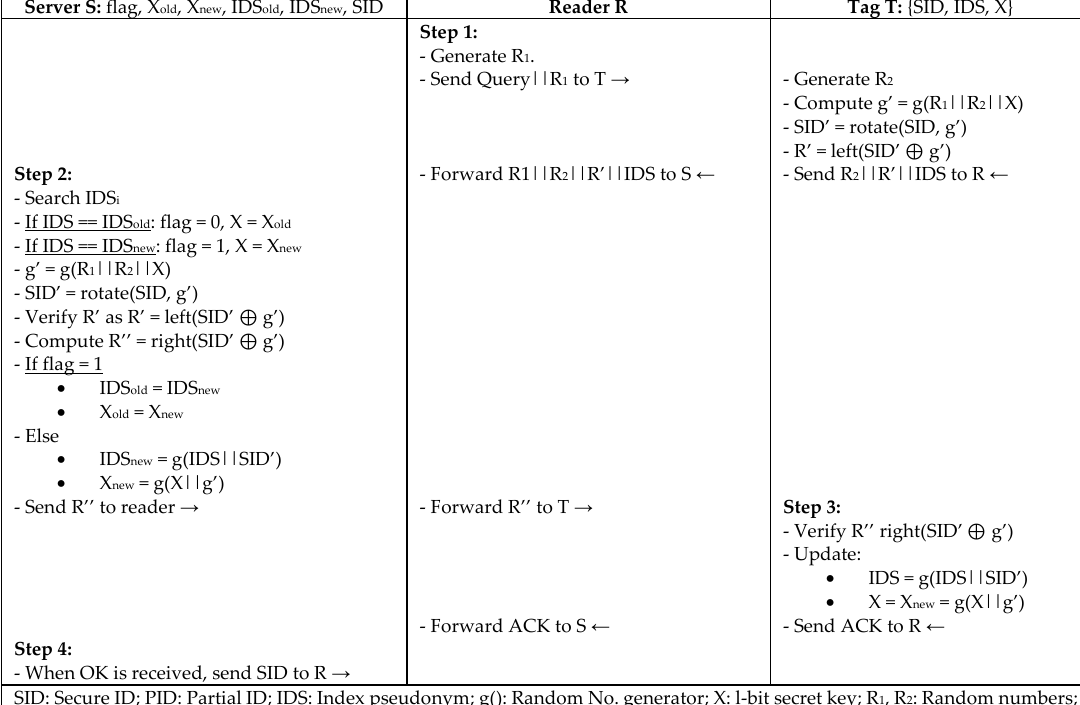
Figure 10. Lightweight Authentication Protocol (LAP) by Chien.